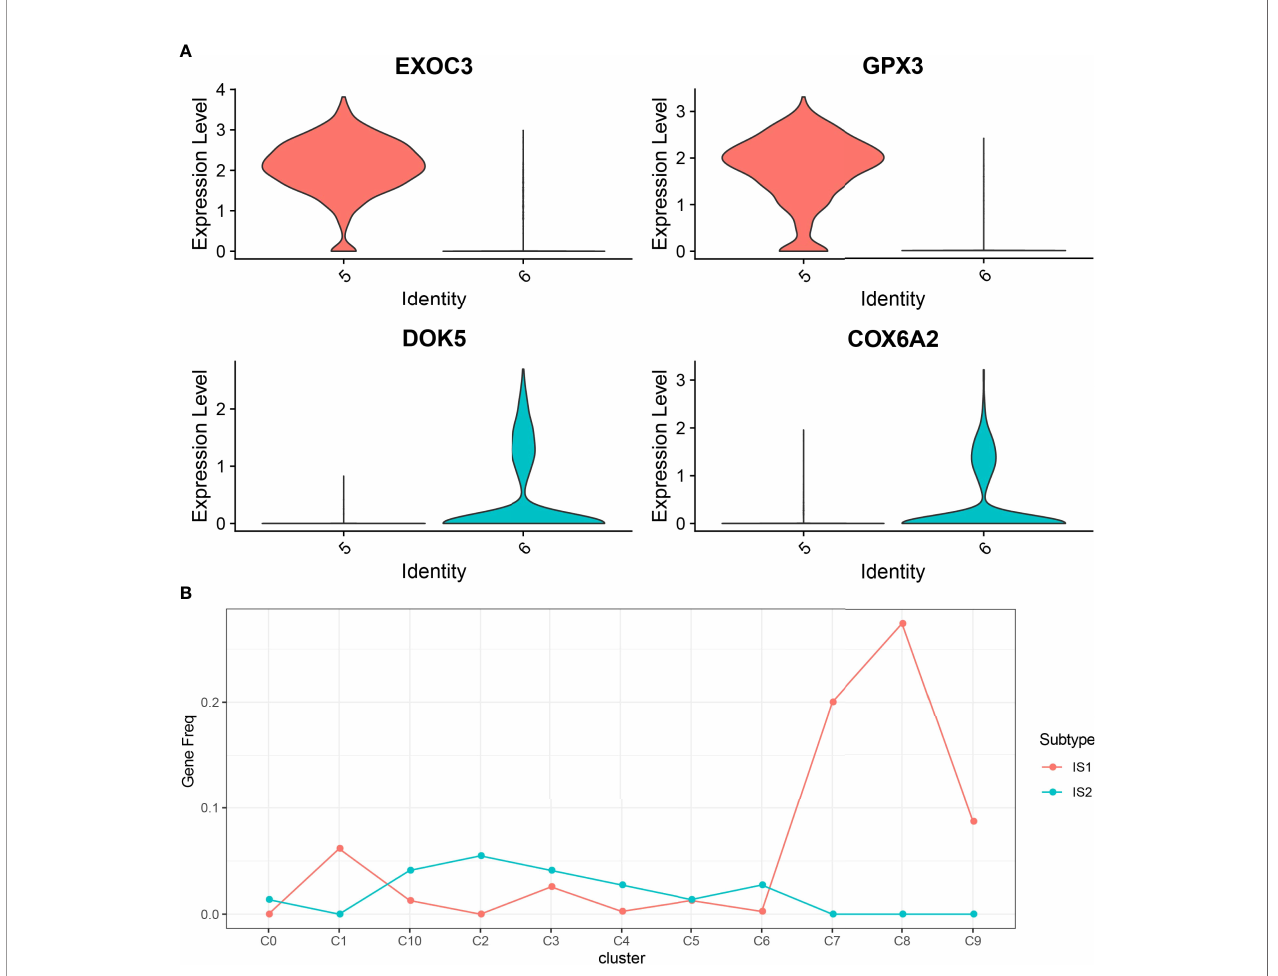
FIGURE 4 | The relationship between 11 cell clusters and two ISs. (A) The violin picture shows the expression of C5 and C6 speci fi c genes in two cell clusters. (B) The level of marker genes of 11 cell clusters in IS1 and